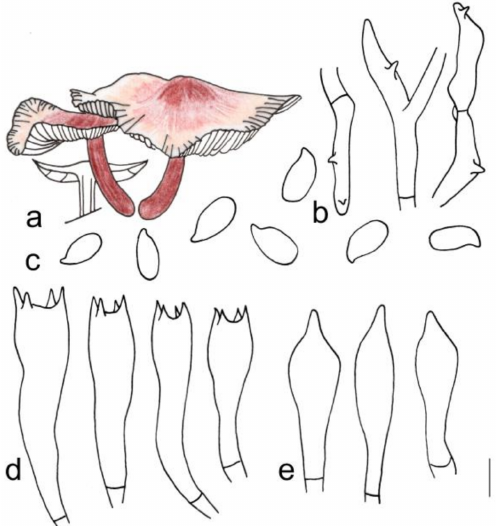
Figure 10. Morphological characteristics of Gymnopus tiliicola (HMJAU 60304, holotype): ( a ) basid- iomata, ( b ) pileipellis, ( c ) basidiospores, ( d ) basidia, and ( e ) cheilocystidia. Scale bars: 1 cm ( a ), 25 µ m ( b ), and 5 µ m ( c – e